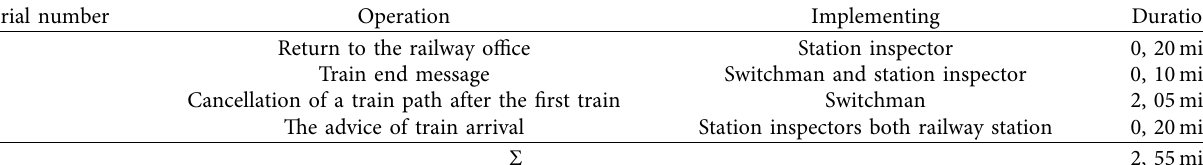
Table 6: Calculation of station component t